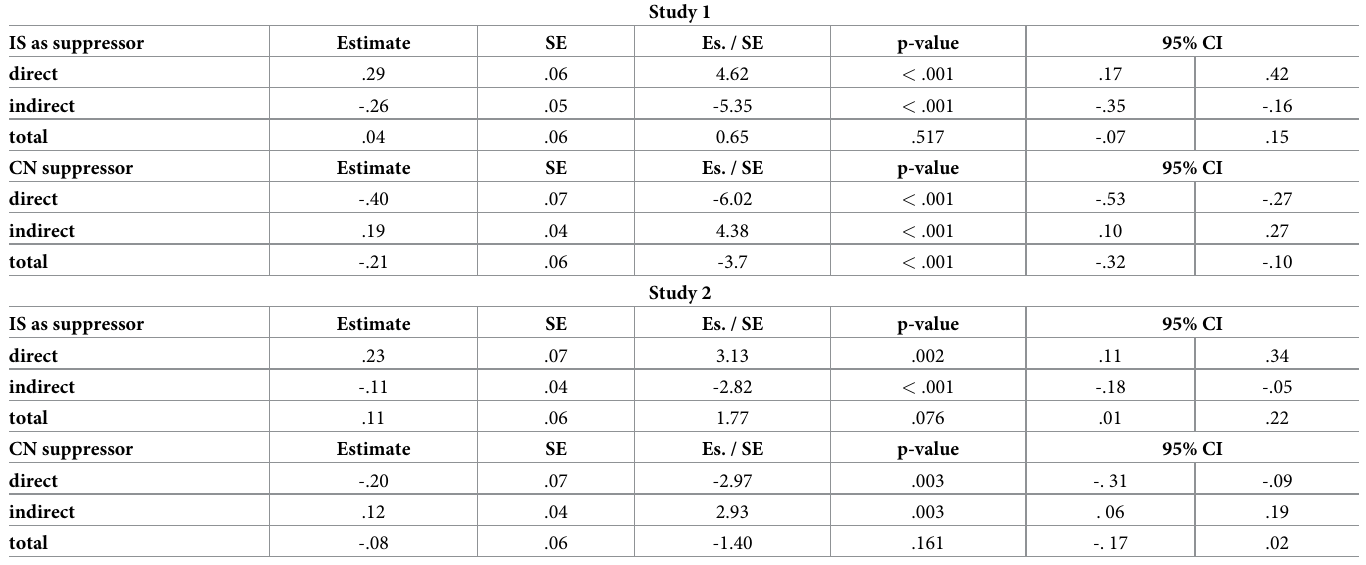
Table 2. Summary of suppression effects for Studies 1 and